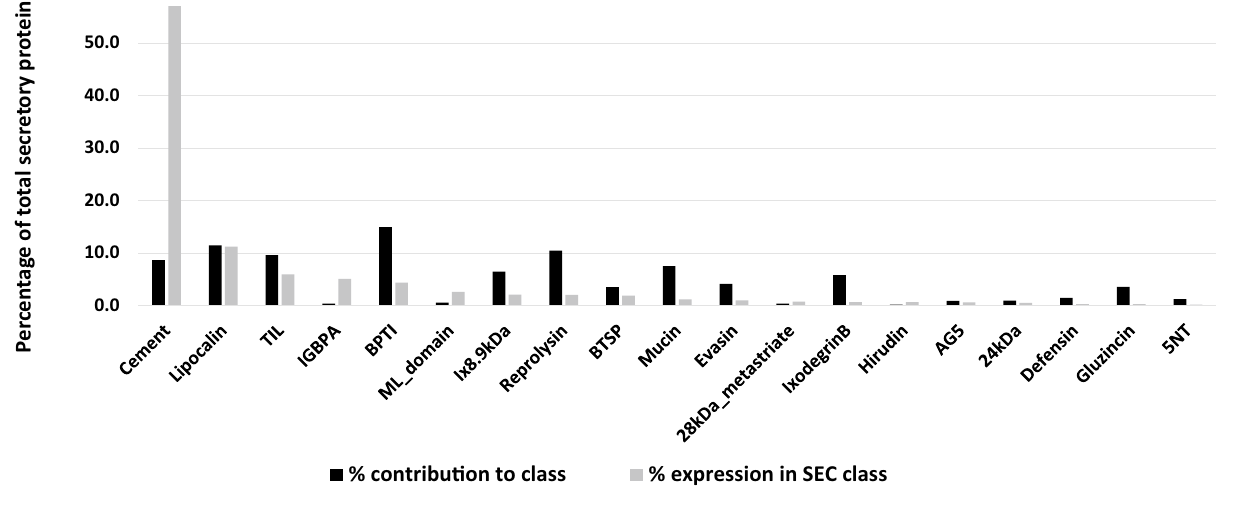
Figure 4. Expression analysis of the secretory (SEC) proteins in the Rhipicephalus evertsi evertsi transcriptome (n = 2040). The glycine-rich protein family (cement) accounted for 57% of the total expression within the class while contributing less than 10 percent of the transcripts in the class. Expression was measured by transcript per million (TPM).